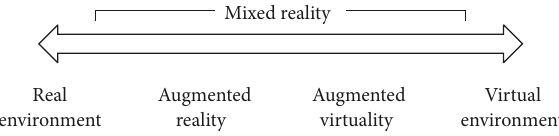
Figure 1: Milgram’s mixed reality continuum